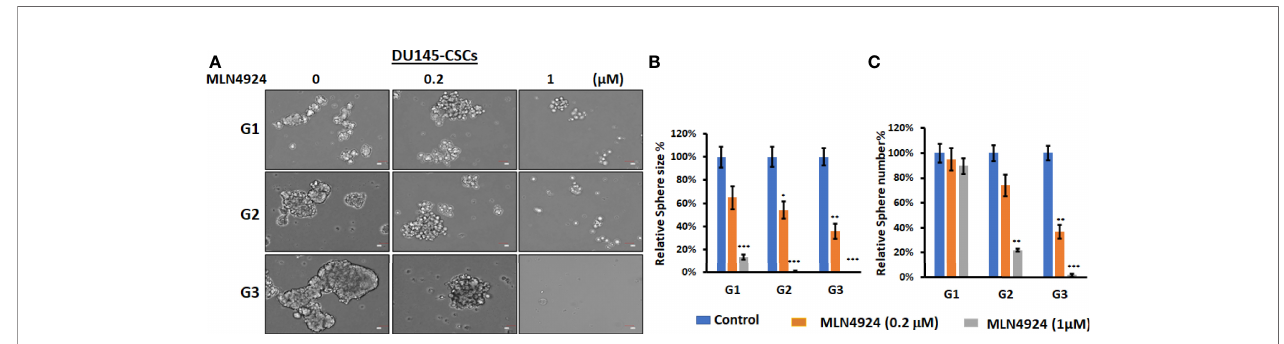
FIGURE 5 | MLN4924 inhibits CSC prostasphere formation. (A) Prostaspheres generated from DU145 with indicated treatment every 3 days for 14 days at G1 generation and without any treatments at G2 and G3 generations were imaged, Scale bar: 50 µm. *P<0.5, **P<0.01, ***P<0.001. (B, C) The numbers and sizes of prostaspheres were analyzed, and percentage changes from FKA treatments relative to control treatments are